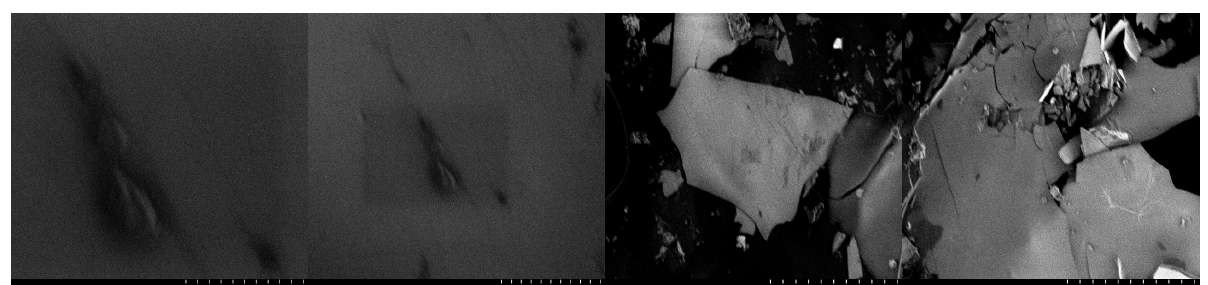
Figure 4. SEM images of MK sample.